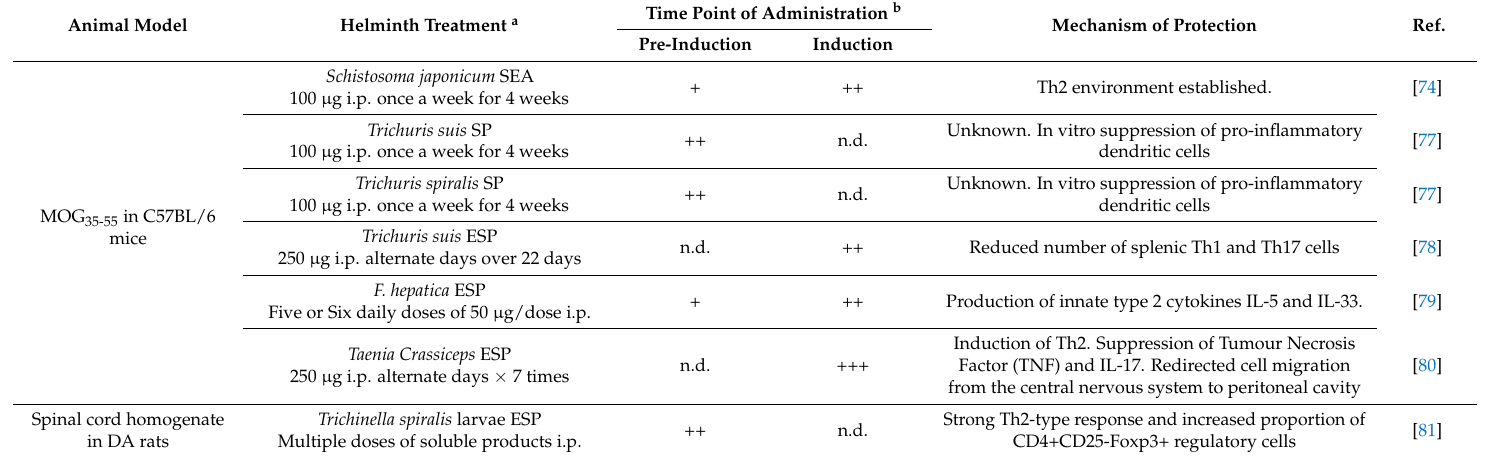
Table 3. Experimental studies assessing the protective effect of helminth soluble products in animal models of